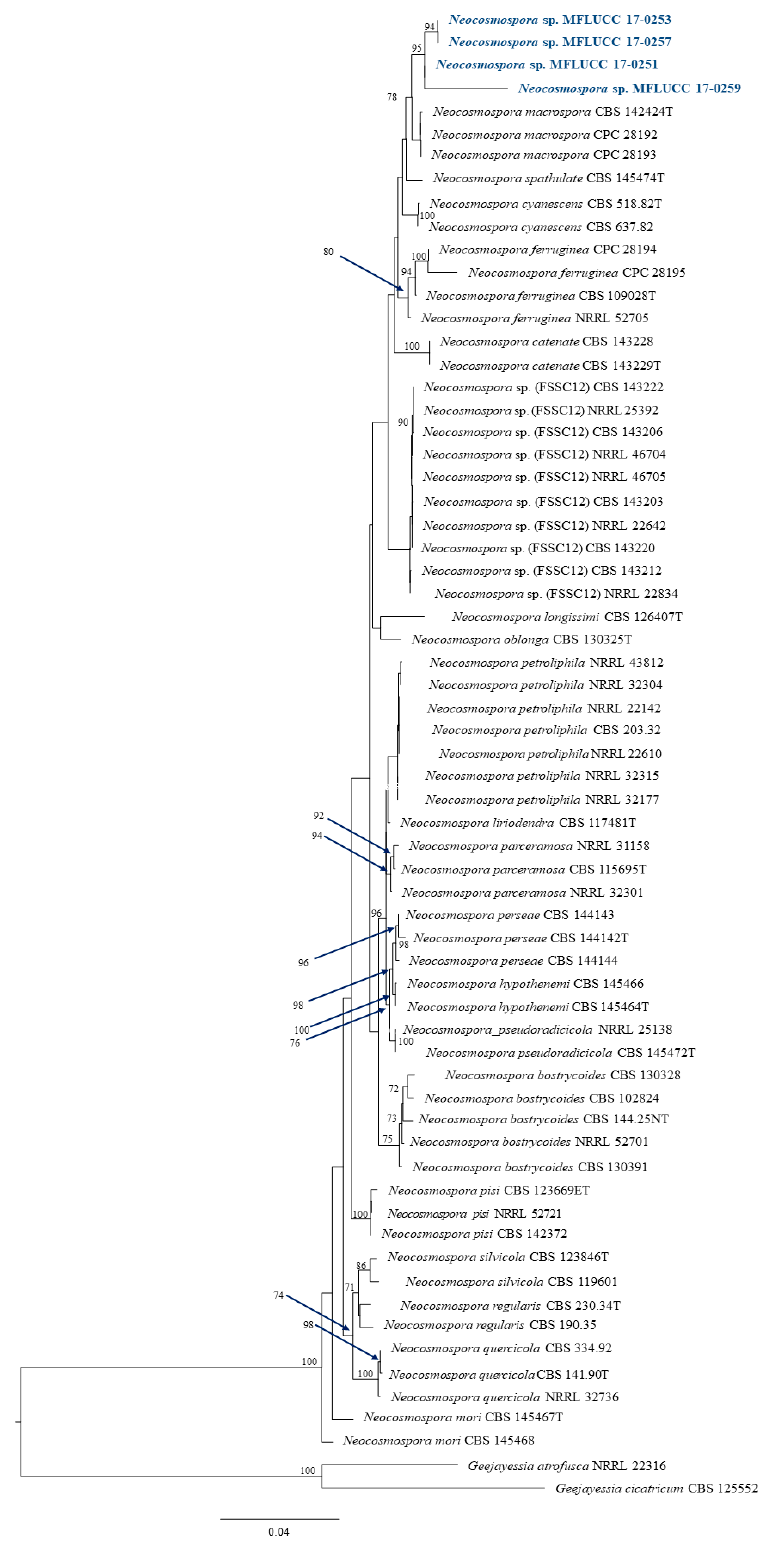
Figure 3. Phylogram generated from a RAxML analysis based on ITS, TEF1, LSU and RPB2 sequence data. Bootstrap support values for ML equal to or greater than 60% above the nodes. The tree is rooted to Geejayessia atrofusca (NRRL 22316) and Geejayessia cicatricum (CBS 125552), Blue arrows indicate bootstrap support for the node at which they point.